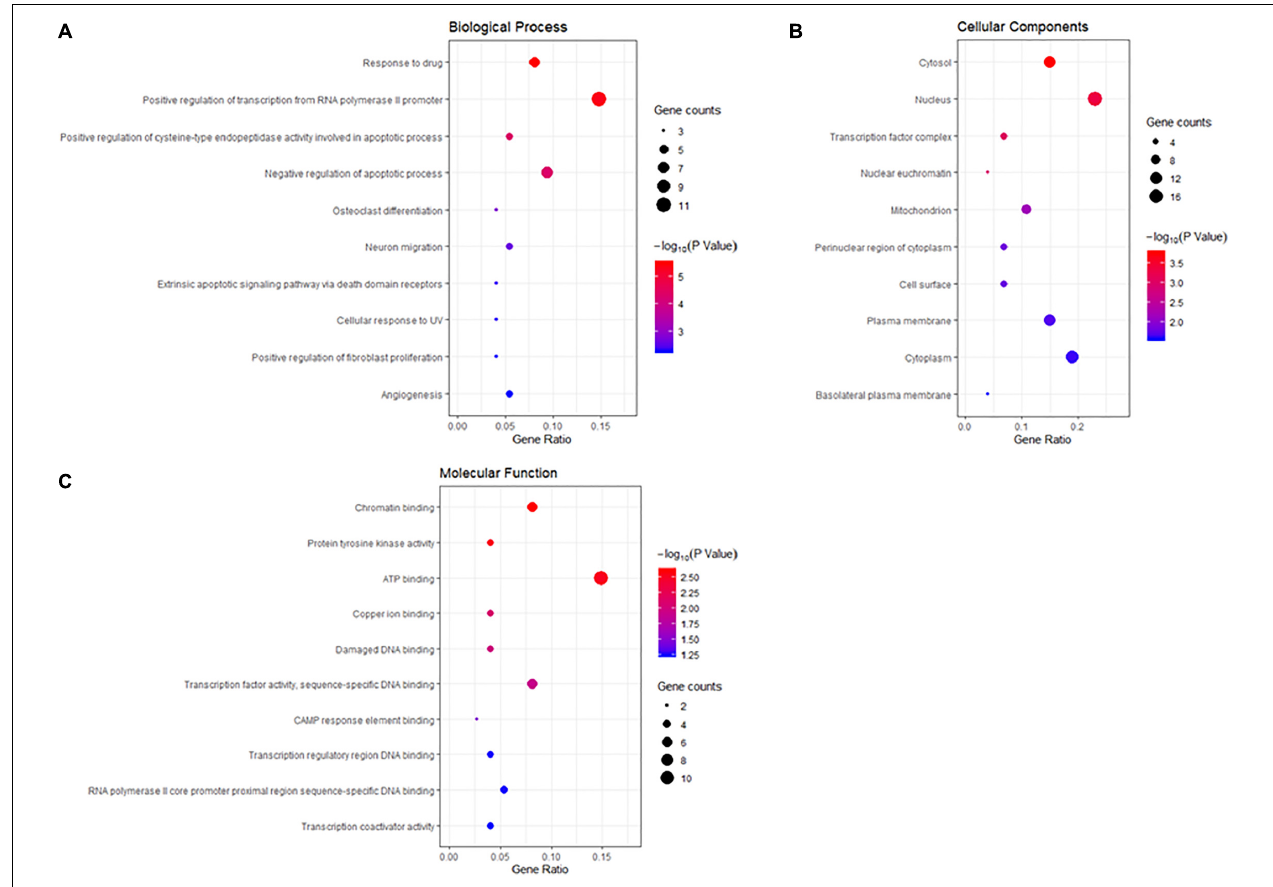
FIGURE 5 | Gene ontology (GO) enrichment analysis of the quercetin target genes. (A) The plot of enriched biological processes. (B) The plot of enriched cellular components. (C) The plot of enriched molecular functions. The number of genes enriched in each GO term is shown as the circle size, the p -value shown as different